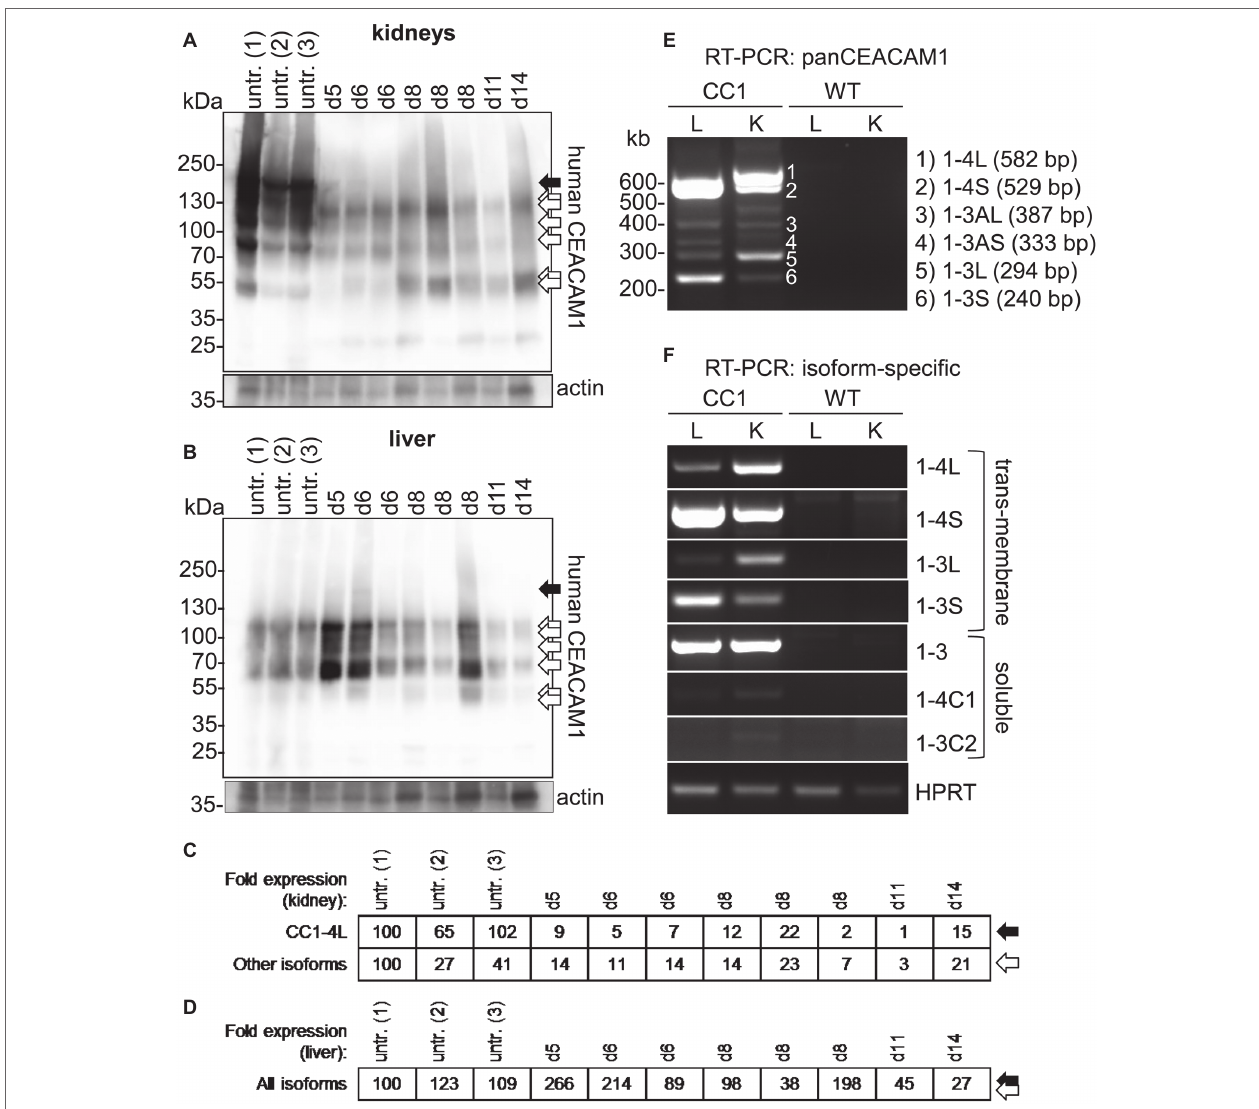
FIGURE 6 | Organ-specific regulation of CEACAM1 expression during systemic C. albicans infection. (A,B) Human CEACAM1-transgenic mice were either sacrificed untreated (“untr.”) or injected with 1 × 10 5 CFU C. albicans /g body weight (corresponding to a total of 2 × 10 6 CFU for a mouse of 20 g body weight) into the tail vein and sacrificed when reaching a humane endpoint (mice from Figures 5F – J ; “endpoint”). Kidneys (A) and livers (B) were removed at the time of death and analyzed by Western blot for their human CEACAM1 expression. Actin re-blots served as loading controls. For infected animals, the time of death is given in days above the lanes (d5 to d14). Black arrows indicate the largest isoform, CEACAM1-4L. Open arrows indicate smaller isoforms, which could not be distinguished by Western blot. (C,D) Quantification of relative CEACAM1 expression. Please note the lack of cross-reactivity of the anti-human CEACAM1 antibody with mouse CEACAM1 as shown in Supplementary Figure 4 . In kidney samples, CEACAM1-4L and all remaining CEACAM1 signals were quantified and adjusted to the respective actin signals (C) . In liver samples, total CEACAM1 signals were quantified and adjusted to the respective actin signals (D) . Data are representative from one of two experiments shown in Figure 5F . (E,F) RT-PCR analysis of human CEACAM1 isoforms expressed in livers (“L”) and kidneys (“K”) of untreated human CEACAM1 transgenic mice (“CC1”). Wild-type mice served as controls (“WT”). (E) PanCEACAM1 primers were able to detect all transmembrane isoforms containing exons 4 and 9, resulting in multiple products. Corresponding human CEACAM1 isoforms were assigned to the numbered signals, and the expected product size is given in brackets, respectively. (F) Isoform-specific, exon-spanning primers were used to detect seven human CEACAM1 isoforms specifically. Note that the HPRT1-positive controls shown in Panel (F) also apply to the panCEACAM1 RT-PCR (E) , as all samples were analyzed in parallel. Results are representative for three human CEACAM1 transgenic